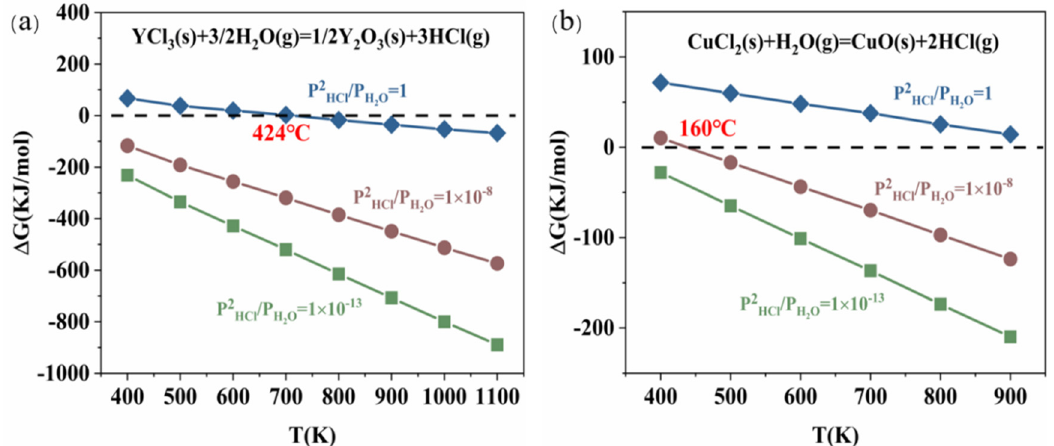
Figure 8. Gibbs free energy changes under different proportions of exhaust gas partial pressure and water pressure: ( a ) YCl 3 reacts with water vapor; ( b ) reaction of CuCl 2 with water